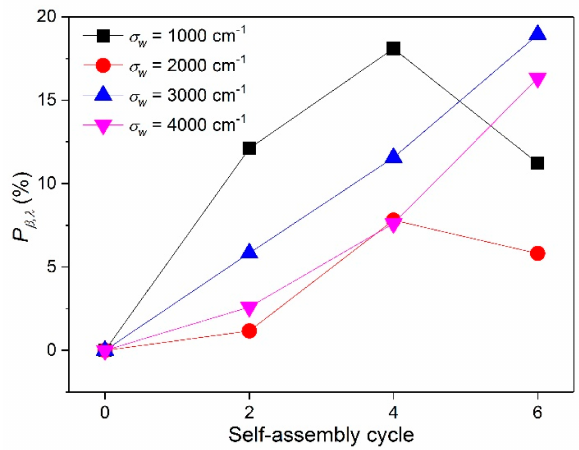
Figure 9. Increment percentage of spectral extinction coefficient at different wavenumbers.